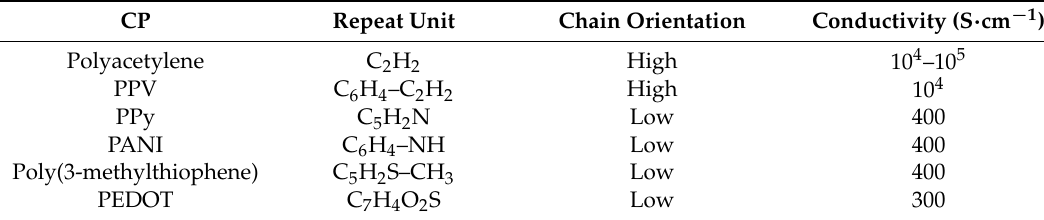
Table 1. CPs in which a maximum metallic state has been observed in the doped state